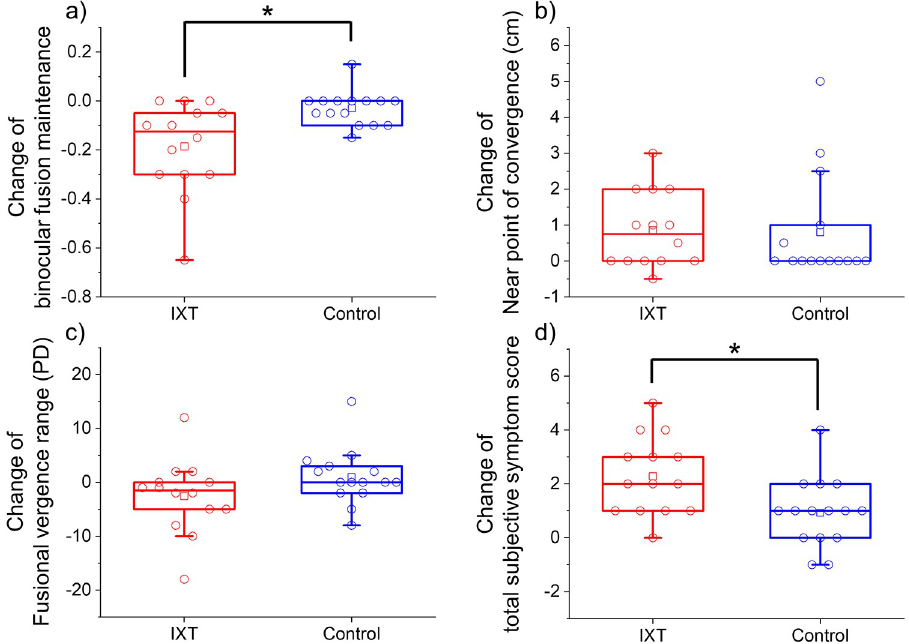
Fig 5. Changes in binocular fusion maintenance (BFM) (a), near point of convergence (NPC) (b), fusional vergence range (c), and total subjective eye symptom score (b) in the intermittent exotropia (IXT) (red) and control (blue) groups. The red and blue circles indicate individual BFM, NPC, fusional vergence range, and total subjective eye symptom scores (Q1 + Q2 + Q3) in the IXT and control groups. � P < 0.05, Mann–Whitney U test.